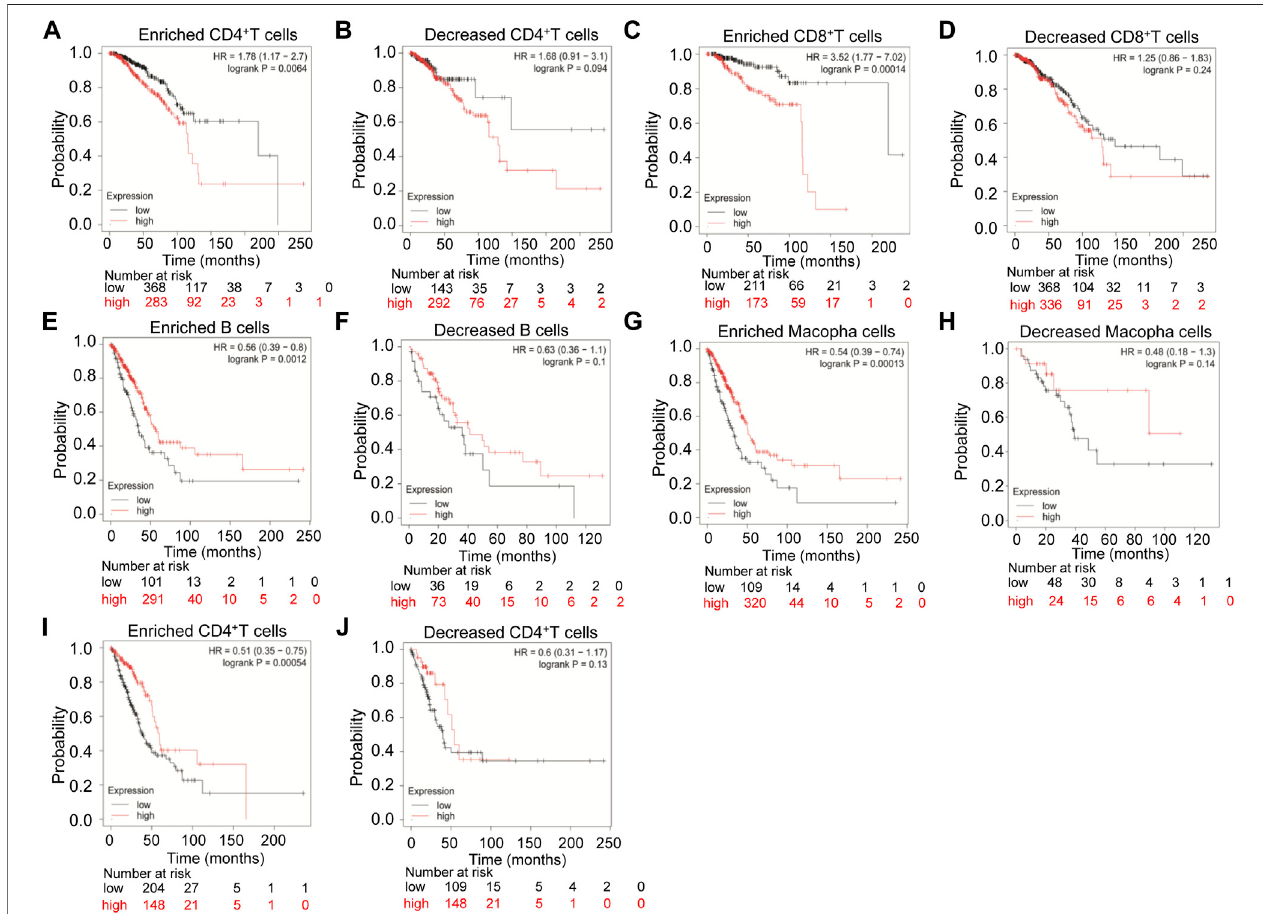
FIGURE 5 | Kaplan-Meier survival curves compare the high and low expression levels of TMPRSS2 in breast cancer and LUAD based on immune cells. The prognosis of various expression of TMPRSS2 correlated with immune cells in breast cancer (A – D) , and LUAD (E – J) .